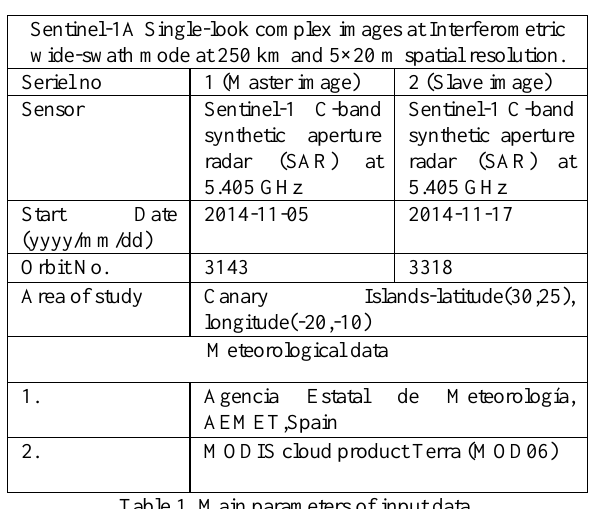
Table 1. Main parameters of input data.